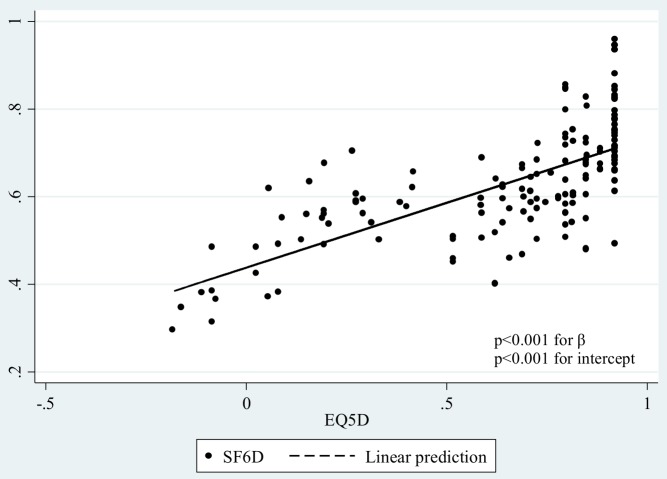
Scatter plot of EQ-5D and SF-6D.